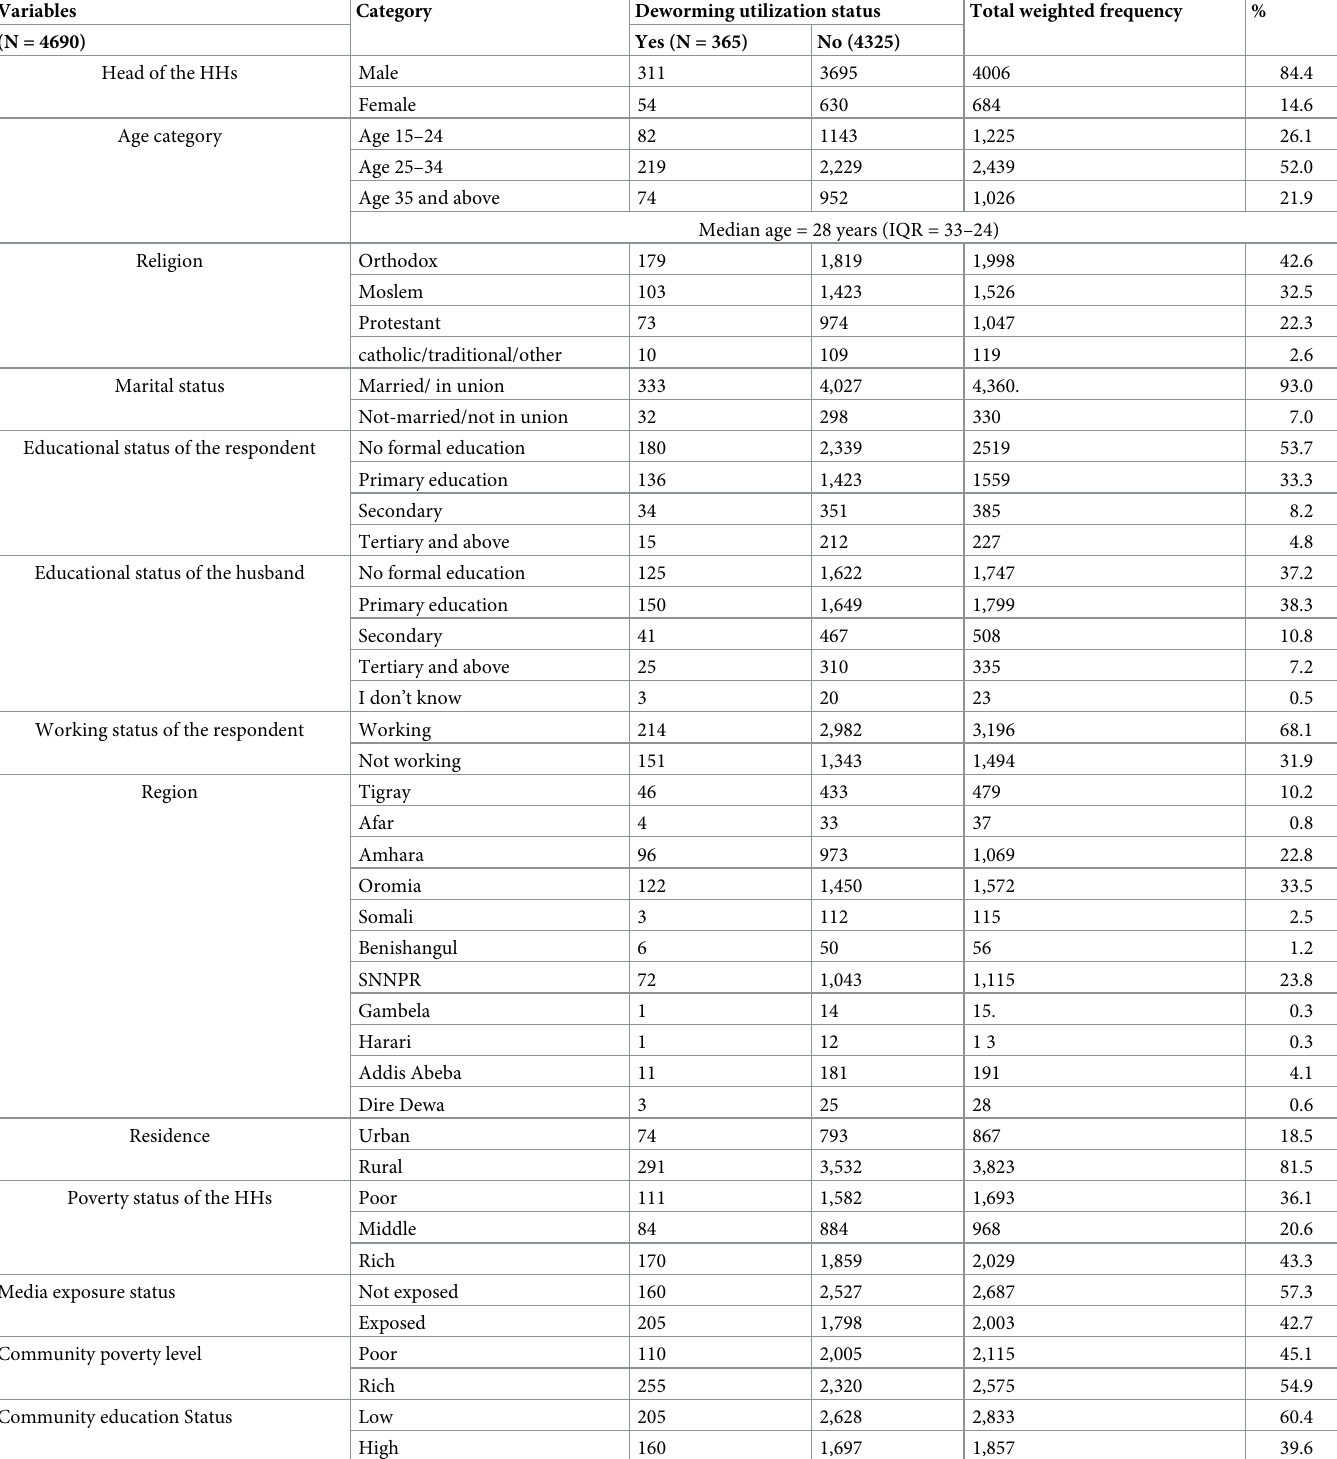
Table 1. Socio-demographic and economic characteristics of respondents in 2016 EDHS, Ethiopia (weighted N =